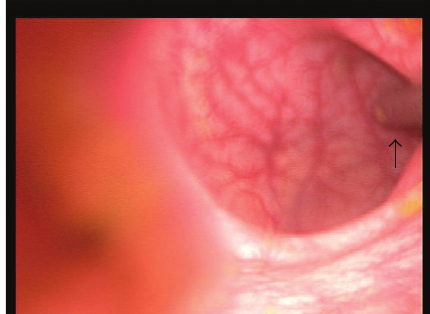
Figure 6: Laparoscopic graspers were used to grasp the rim of the cigar sheath and extract it under laparoscopic